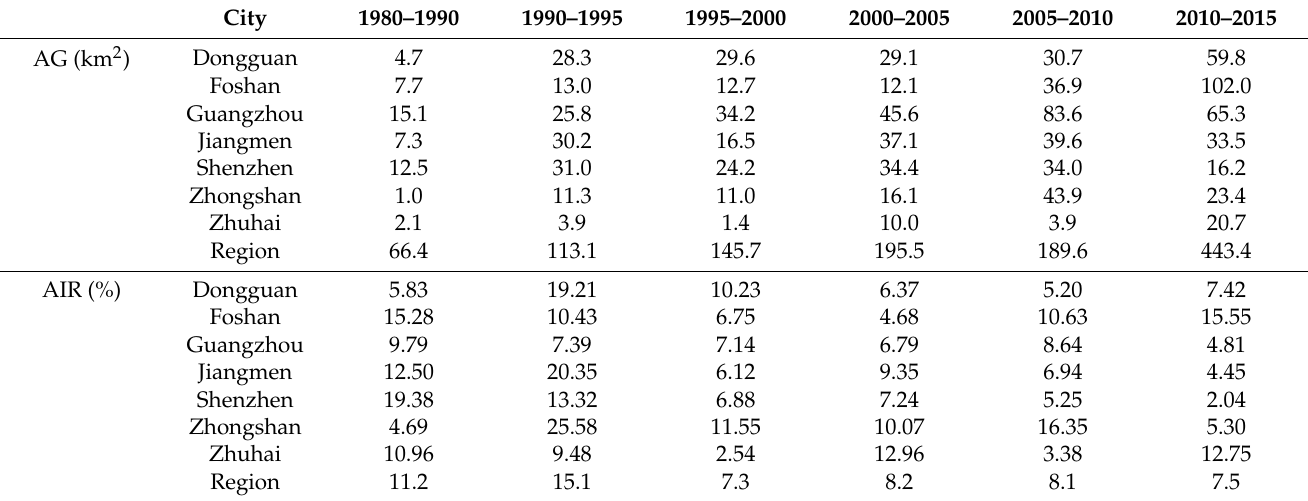
Table 5. Annual Growth (AG) in urban area (km 2 ) and Annual Increase Rate (AIR) (%) of seven cities among six neighboring periods from 1980 to